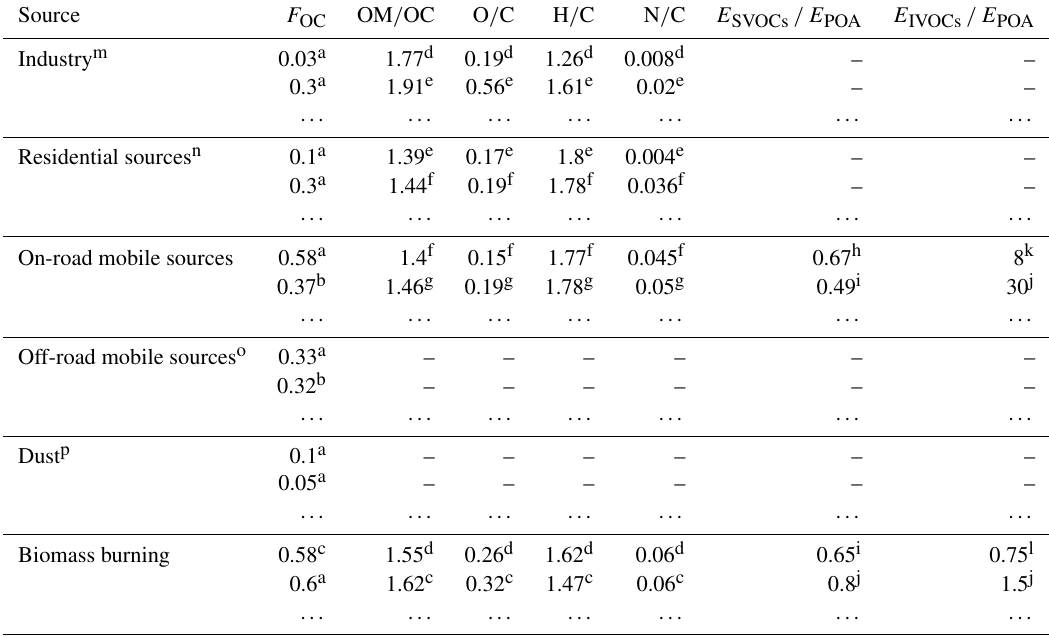
Table 1. Datasets of all input parameters used in the emission inventory model. Ellipses indicate that not all data were present in the table as the number of data was large ( ∼ 400).